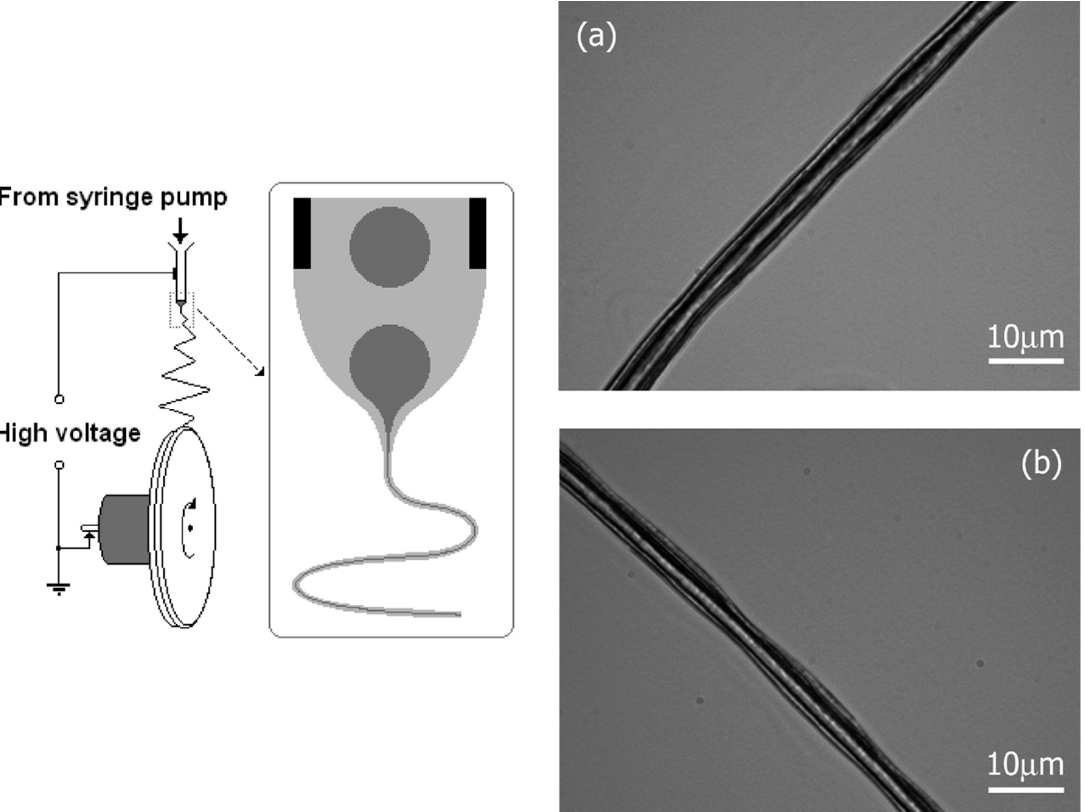
Figure 16. Optical micrograph showing the core–shell structure obtained from electrospinning the emulsion of PMMA/DMF in PAN/DMF ( right ). Note that initial droplets (dark gray) that are shown in the needle detail led to a continuous filament after electrospinning. In ( a , b ), optical images of the as-spun core–shell (PMMA-PAN) microfibers can be observed. The fiber in ( a ) has a relative more uniform inner/outer diameter than ( b ). Reproduced with permission from [227].